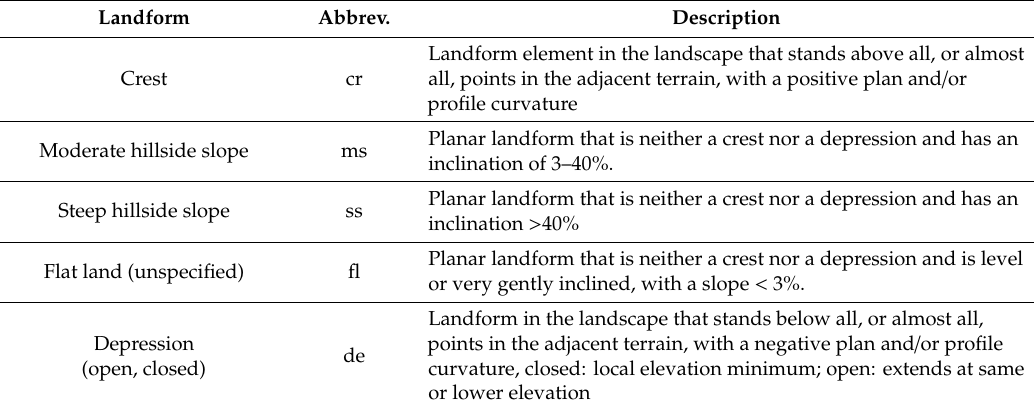
Table 4. Description of landforms according to their morphological type (topographic position) according to Speight (2009) in the study area